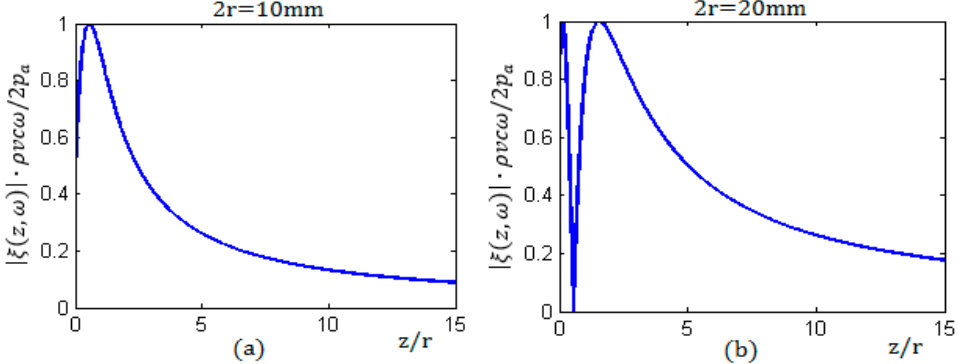
Figure 2. Axial responses of the sound pressure amplitude for the round piston sensors: ( a ) the sensor radius r = 5 mm; and ( b ) the sensor radius r = 10 mm.